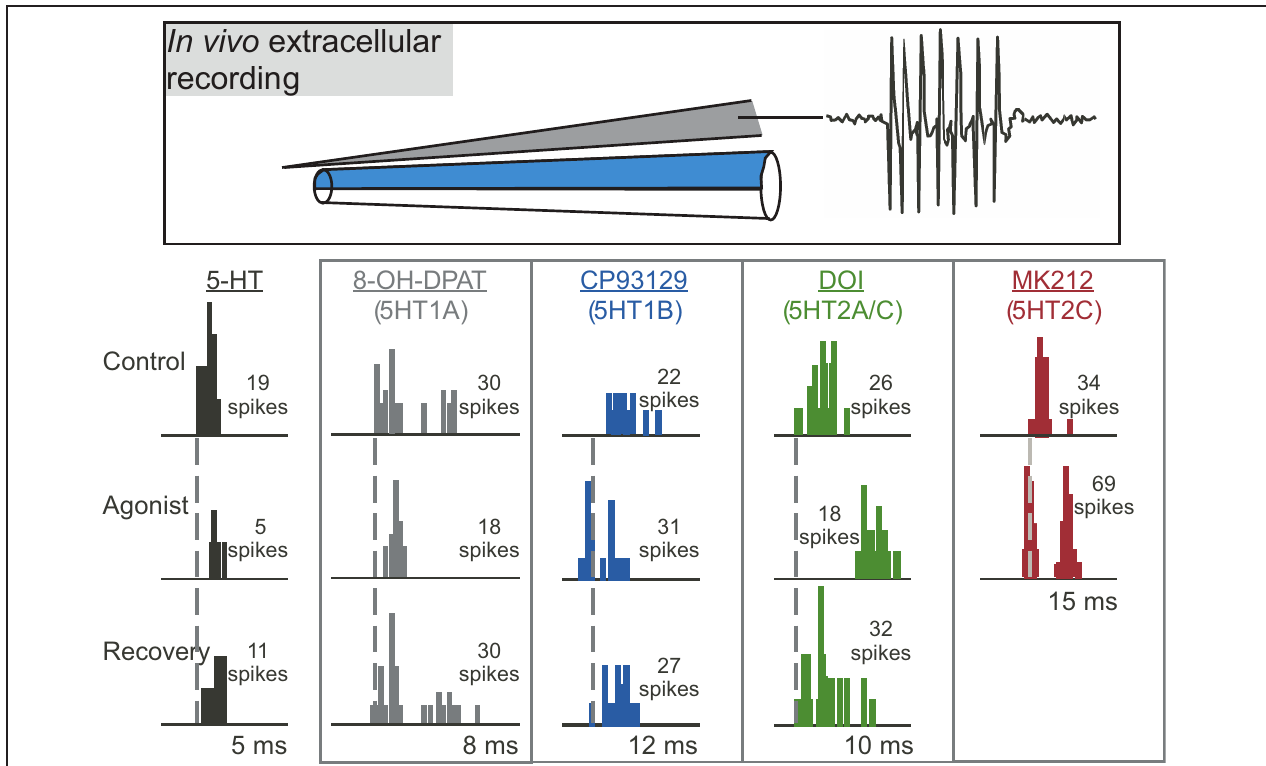
the earliest spikes in the control condition. Stimuli were: for serotonin, a 10-kHz FM sweep centered at 25kHz at 20dB SPL; for 8-OH-DPAT, a 10-kHz FM sweep centered at 25kHz at 40dB SPL; for CP93129, a 20-kHz tone at 20dB SPL; for DOI, a 7-kHz FM sweep centered at 21kHz at 50dB SPL; for MK212, a 5-kHz FM sweep centered at 19kHz at 50dB SPL. All stimuli were 10ms in duration. The lower panel was reprinted from a journal published by the American Physiological Society; additional information on the source article can be found in the